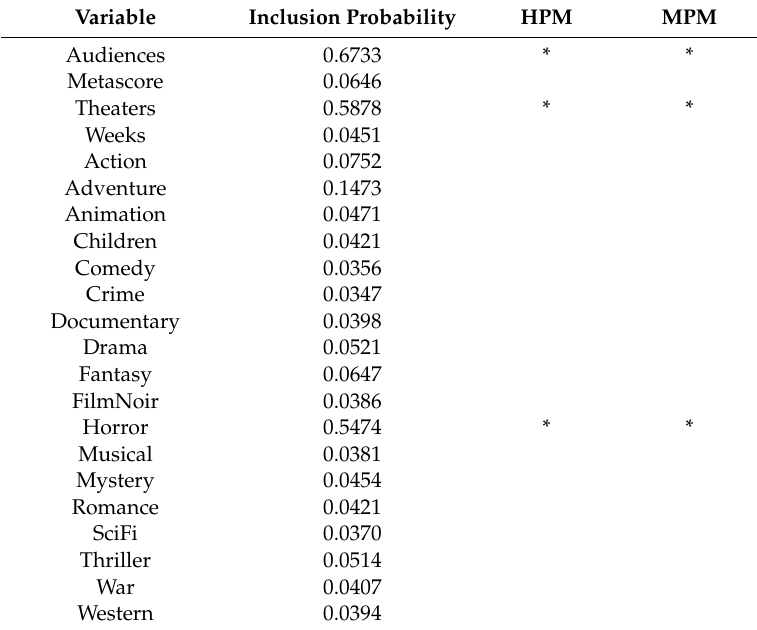
Table 4. Bayesian variable selection method for ROI during Years